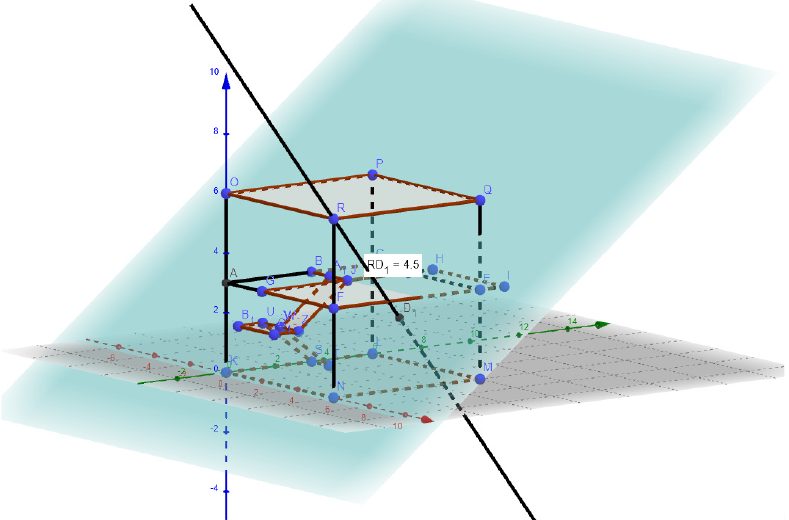
Figure 13. Construction to solve Task 7 in Workshop 2. (Shared in url: https://www.geogebra.org/classic/bsg4x65f, accessed on 29 July 2019).